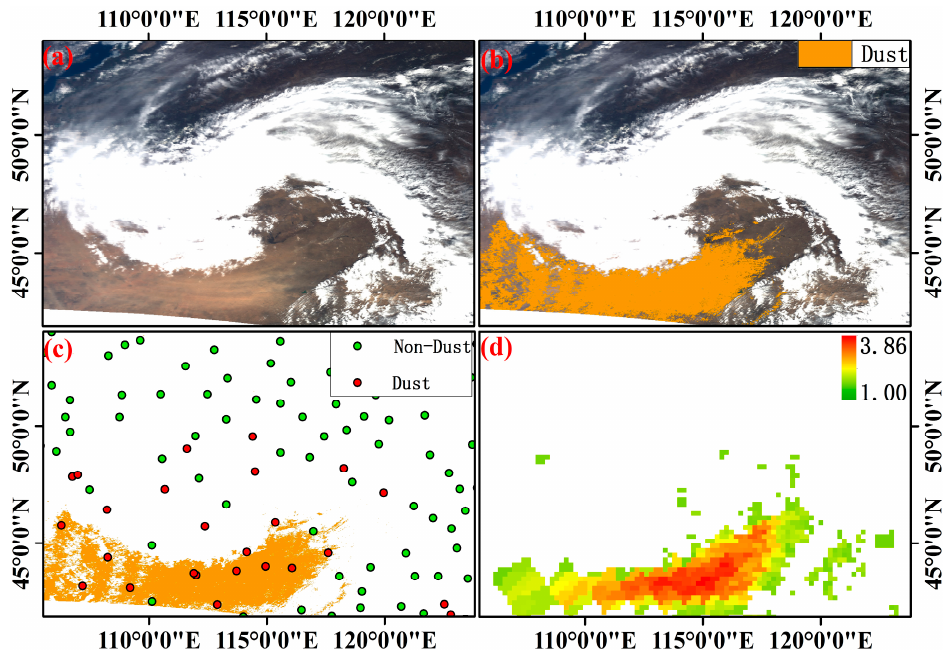
Figure 7. Comparison between the dust storm monitoring result ( b ), MODIS RGB image ( a ), MICAPS data ( c ) and OMI AI data ( d ) on 5 May, 2016.